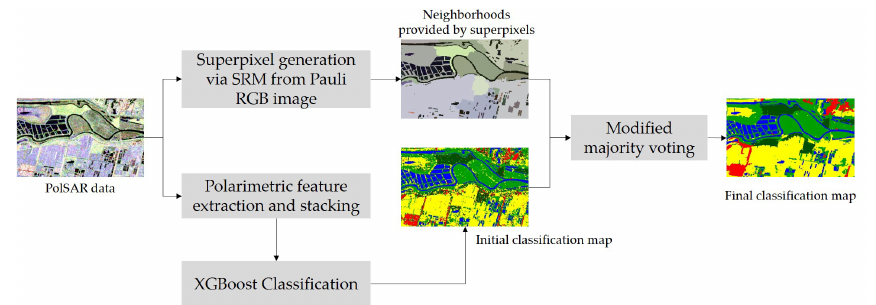
Figure 2. Workflow of the proposed